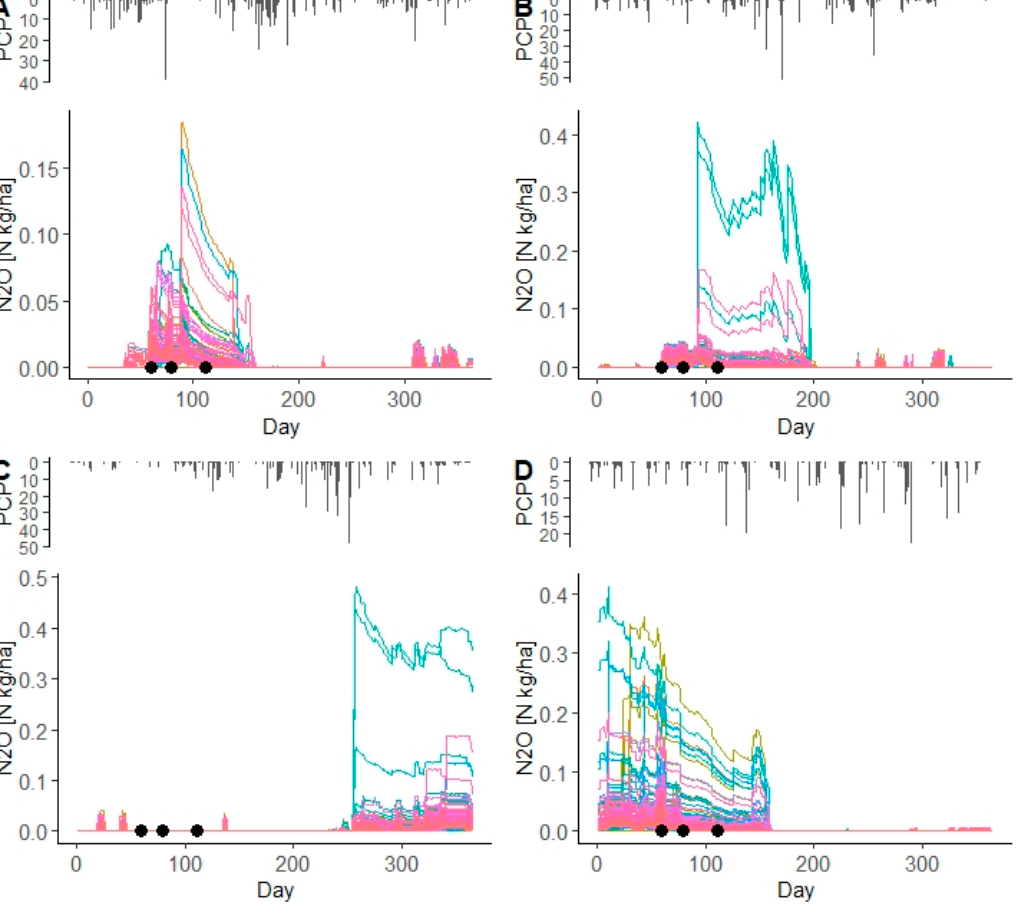
Figure 9. Simulated N 2 O emissions (color lines) from BARL HRUs in the Zaya catchment for the years 2009 ( A ), 2013 ( B ), 2014 ( C ), and 2015 ( D ). PCP is daily precipitation (mm). Black points indicate the dates of N fertilizer application for the setup in the Zaya catchment.